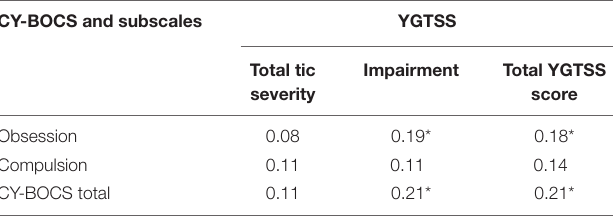
TABLE 3 | The correlation analysis between the CY-BOCS based on YGTSS. CY-BOCS and subscales